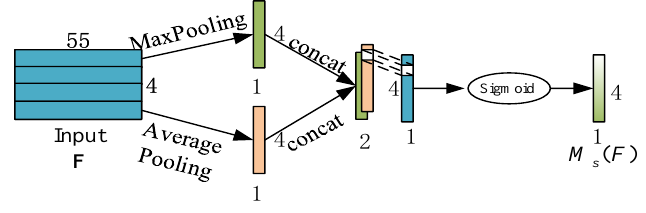
Figure 7. SAM structure diagram.